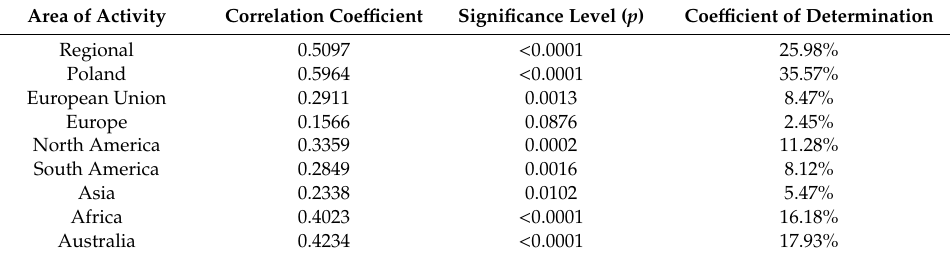
Table 4. Correlation